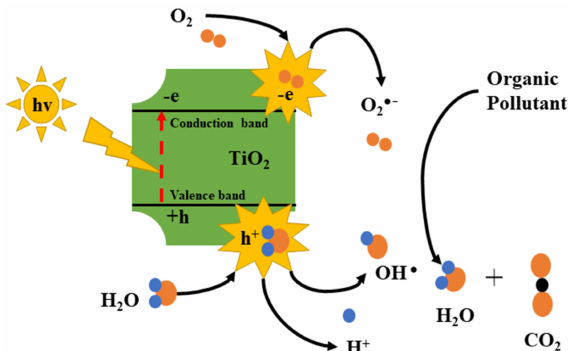
Figure 12. Illustration of basic photodegradation processes using TiO 2